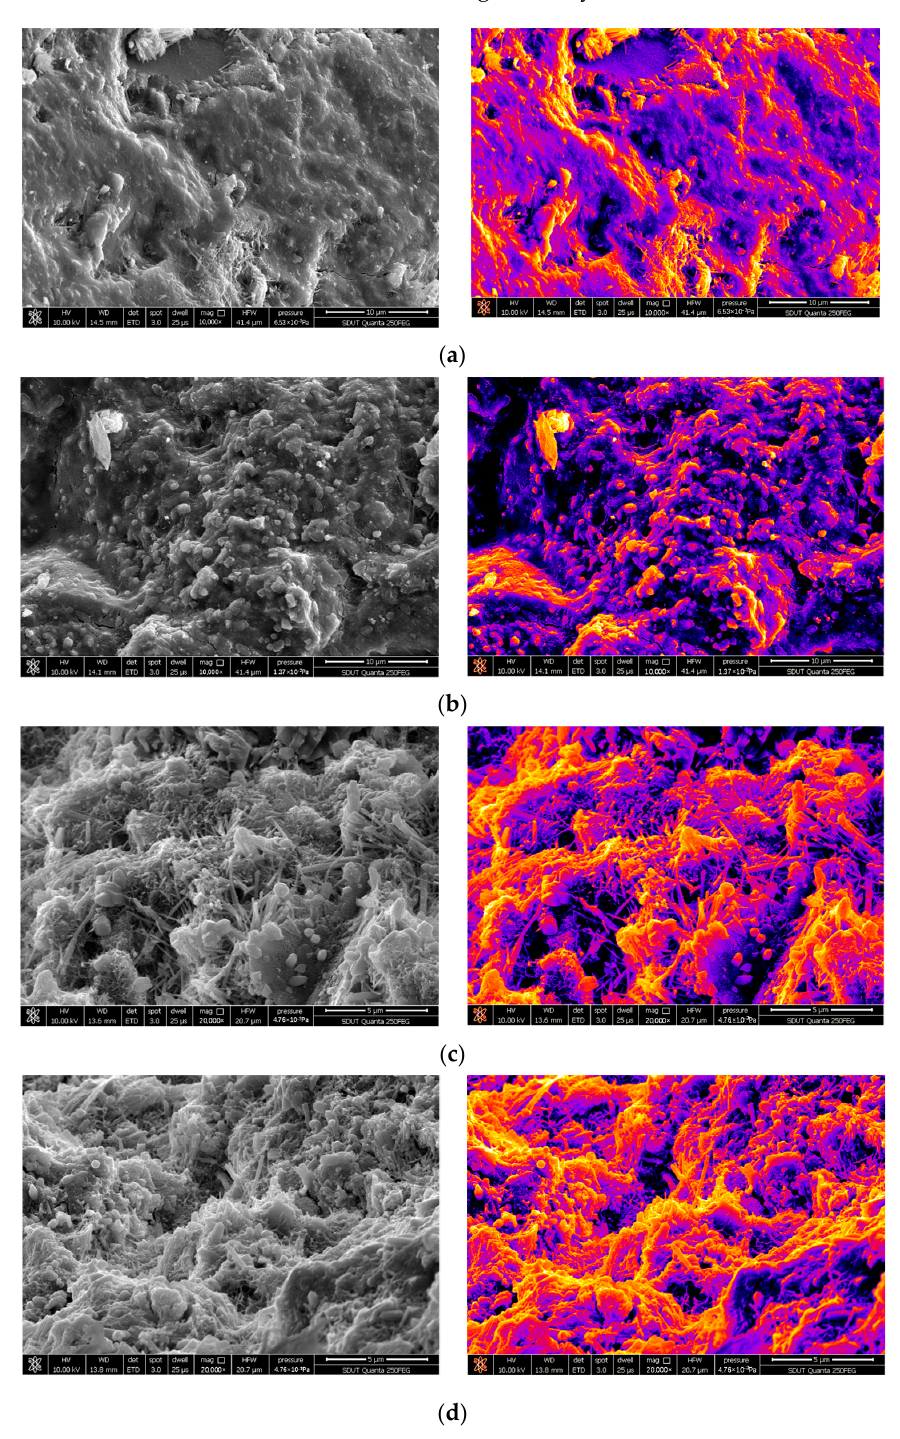
Figure 9. SEM gray scale and depth dyeing: ( a ) NAC section magnified 10,000 times; ( b ) CSAC section magnified 10,000 times; ( c ) NAC section magnified by 20,000 times; ( d ) CSAC section magnified 20,000 times.